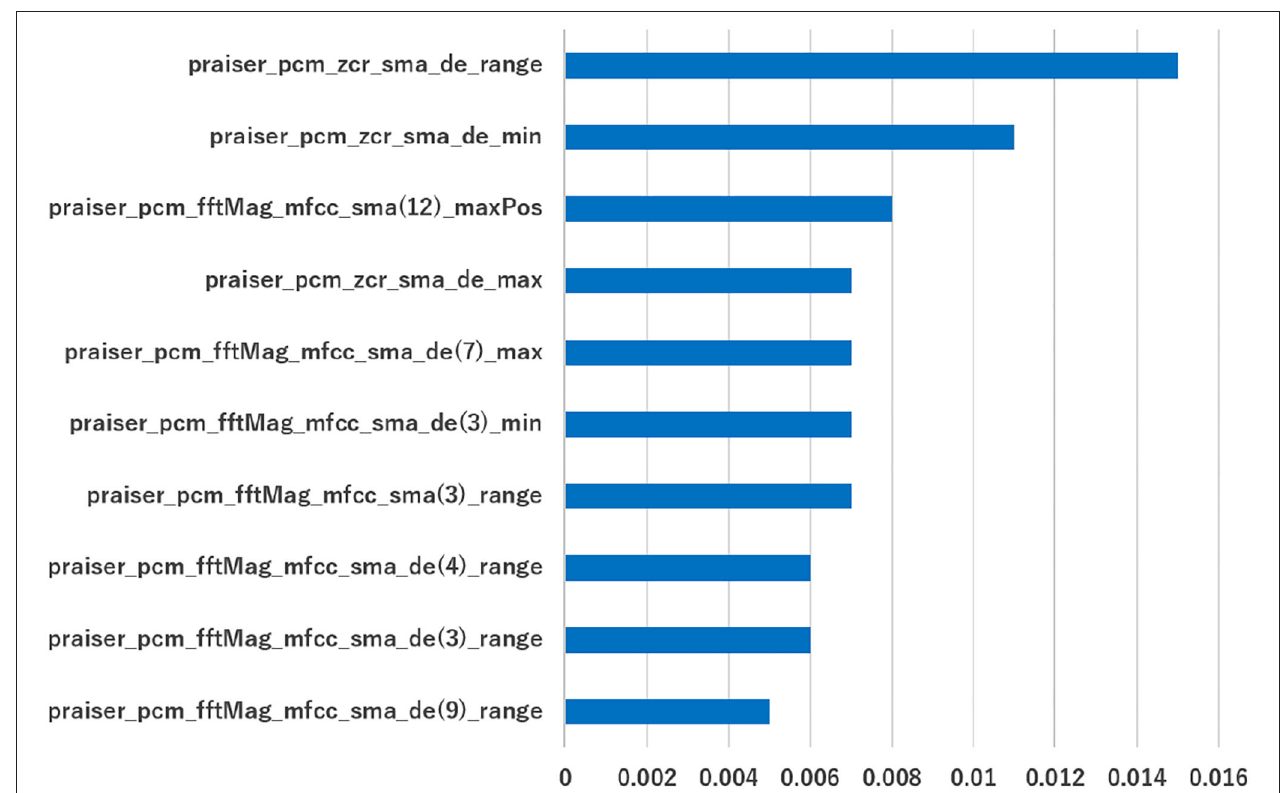
FIGURE 4 | The top 10 features in terms of importance in model M8. The x -axes represent the importance of the features.